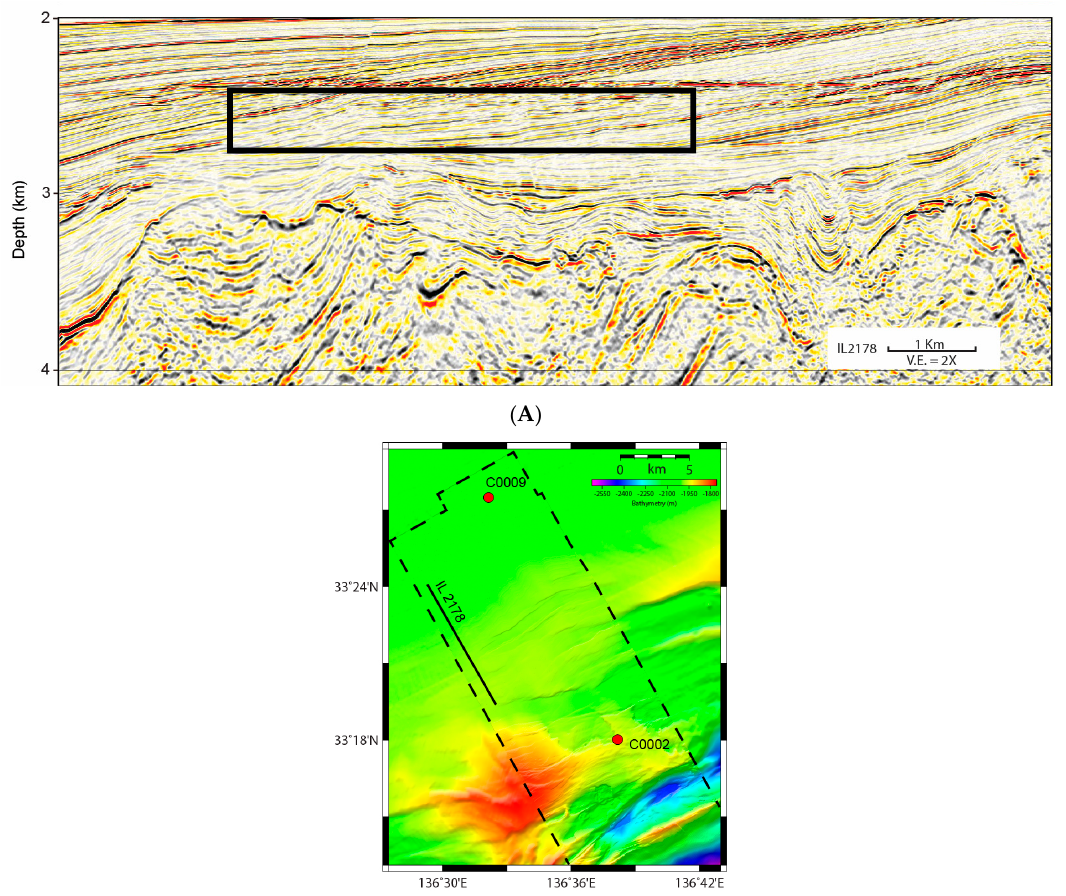
Figure 11. ( A ) Inline 2178. Example of acoustic turbidity (reflectors inside the box) signifying gas beneath the BSR. HARs are abundant directly above the BSR and are likely GH formed by GH recycling. ( B ) Bathymetric map of the study zone with the extent of IL 2178 shown for reference.